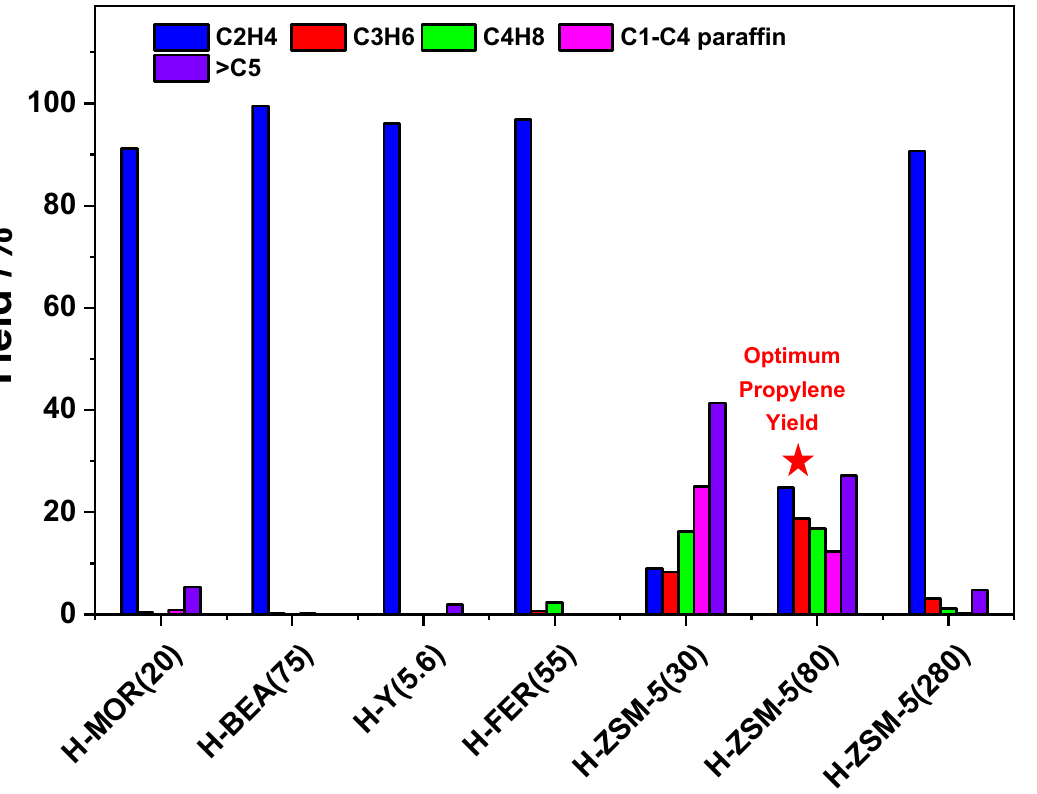
Figure 1. ETO conversion over various zeolites catalysts. Temperature, 400 °C; W/F = 0.0025 g/cm 3 · min − 1 ; EtOH concentration, 50%.